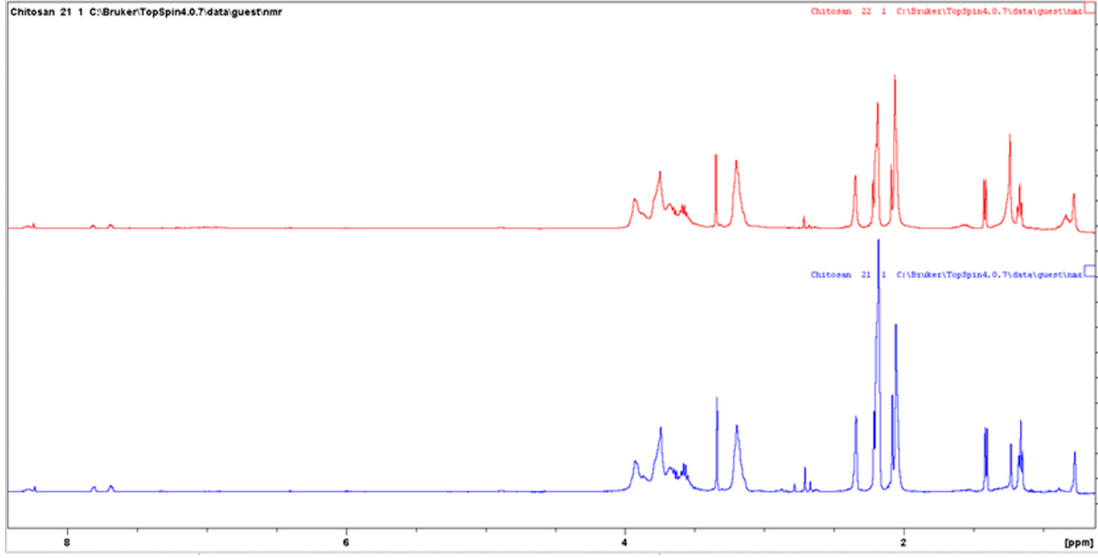
Figure 8. Solution phase 1 H NMR spectra of chitosan (blue) and enzymatically modified chitosan (red). Both samples had the same chitosan concentration (~1.5 mg/mL).